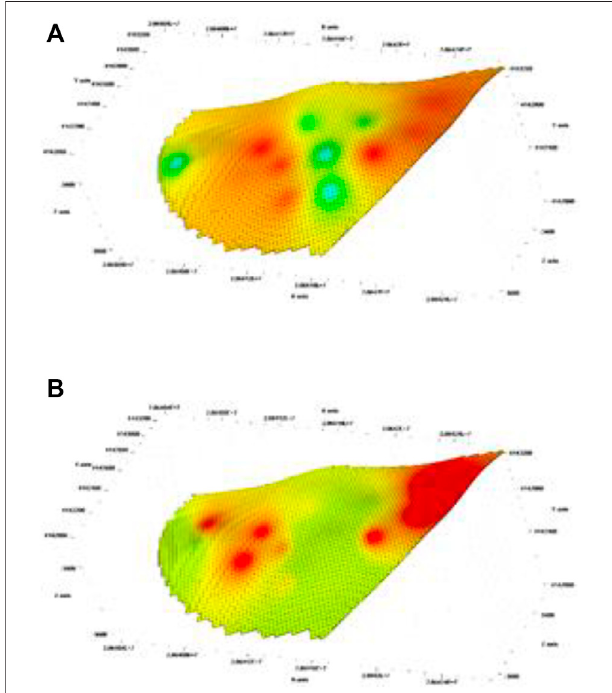
FIGURE 9 | The property models of the No. 3 sand formation, No. 3 sublayer, member 4 of Shahejie Formation in the Wang 587 Block [ (A) permeability; (B) oil